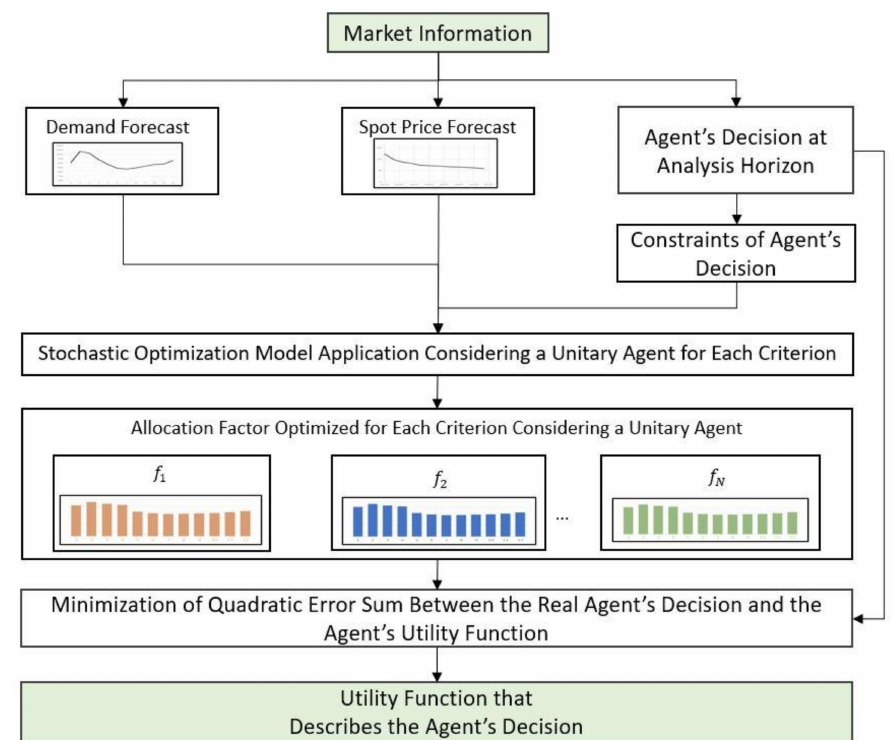
Figure 2. Market intelligence